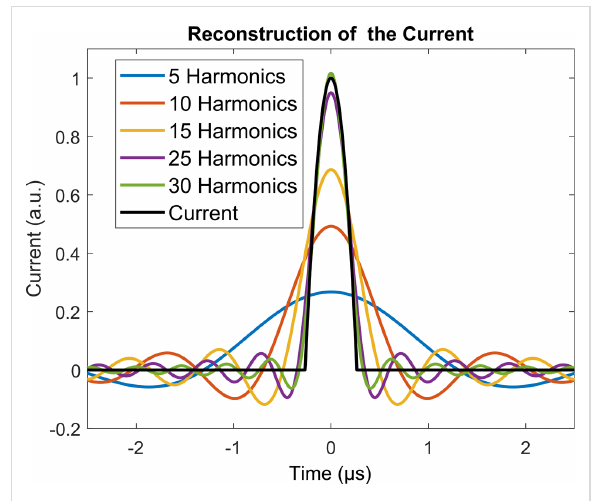
Figure 9: Current output obtained from the intermittent-contact simula- tion (black trace) and reconstruction of the current from different numbers of harmonics. As expected, inclusion of a larger number of harmonics in the reconstruction yields more accurate results. In this particular example, inclusion of 25 harmonics already leads to a very good reconstruction of the current. Since the behaviour of the harmonics coefficients as a function of frequency is not arbitrary, but rather expected to exhibit a sinc-shaped envelope, it may be possible to estimate a large number of higher harmonic amplitudes from a sparse collection of harmonics measured over a wide frequency range, such that a more accurate reconstruction is